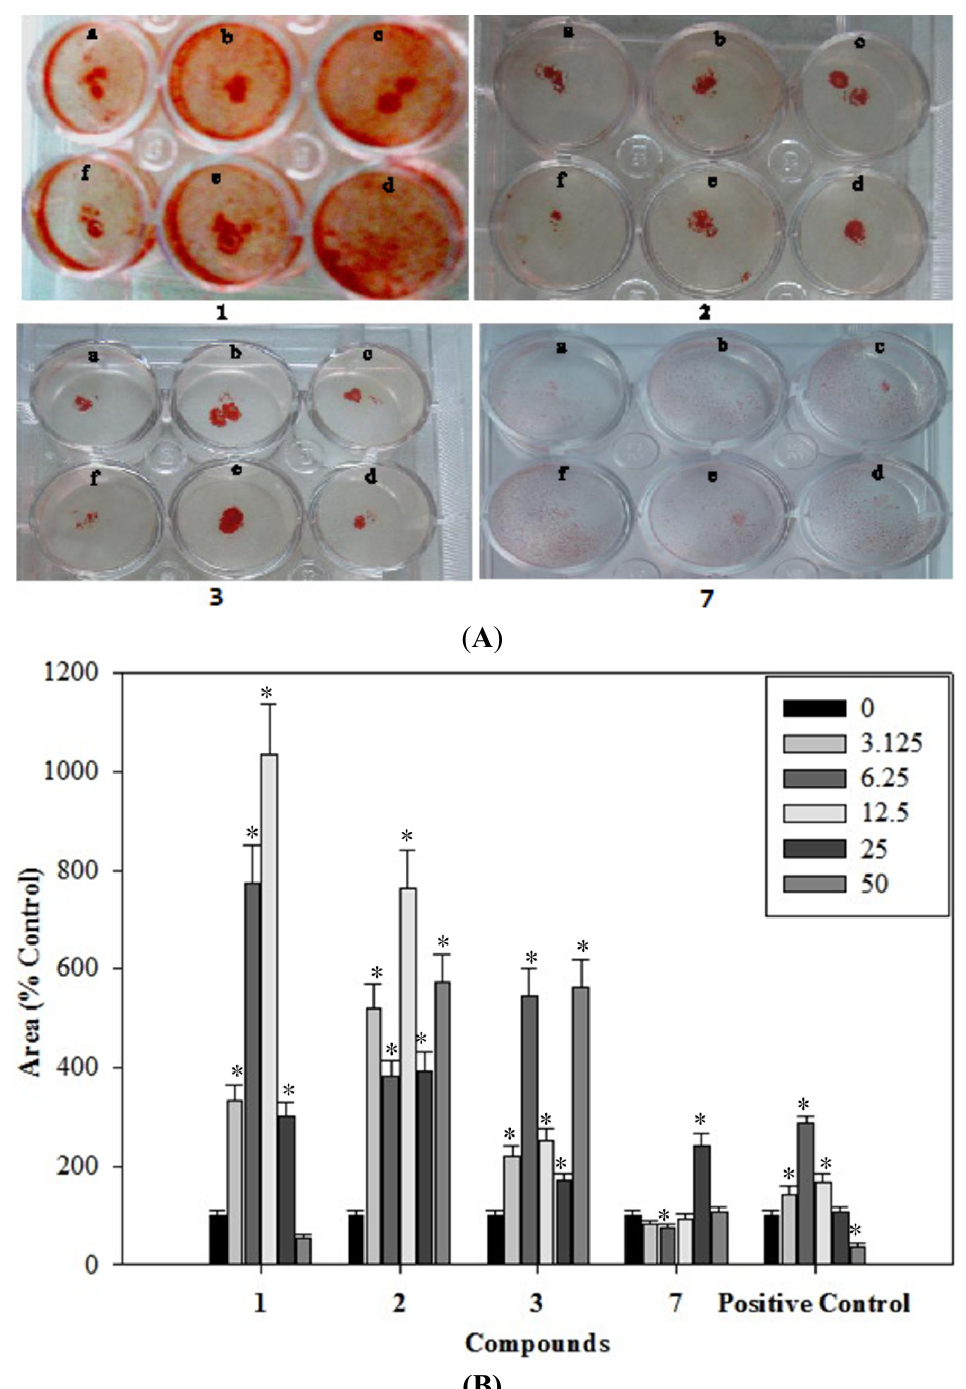
Figure 5. Dose-dependent effects of the phenolics 1 – 3 , 7 on the formation of mineralized nodules in a 12-well plate fixed on Day 20 and stained by alizarin red. ( A ) Cells were treated with the phenolics 1 – 3 , 7 at concentrations of 3.125, 6.25, 12.5, 25, 50 and 0 µg/mL (from a to f) on day 20; and ( B ) Dose-dependent effects of the phenolics 1 – 3 , 7 on the area of mineralized bone nodules stained by alizarin